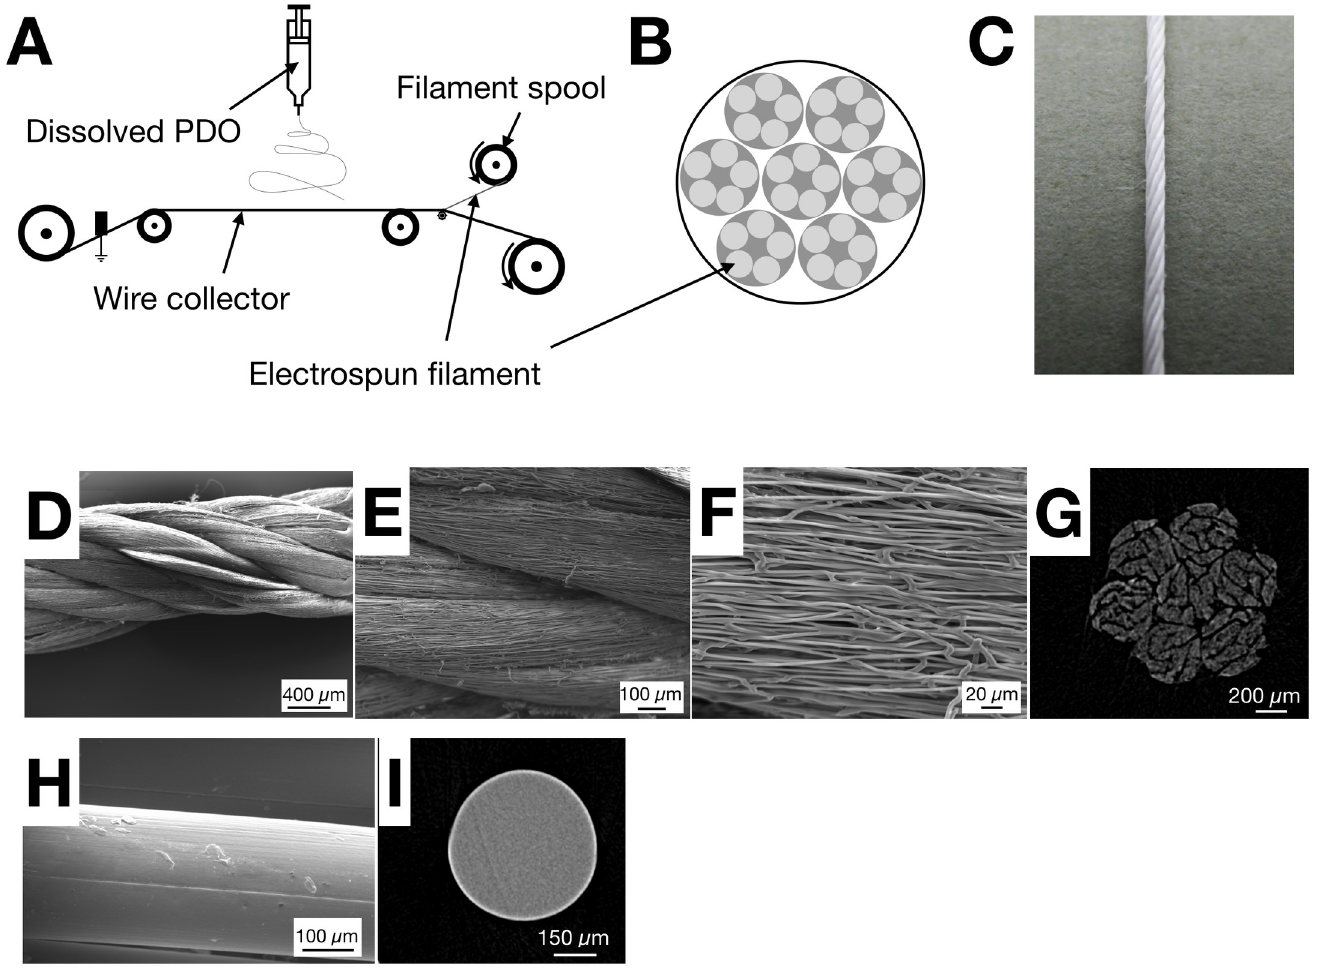
Fig 2. Production and characterisation of electrospun (ES) suture. A) Schematic illustrating the setup for producing ES filaments (building blocks). B) Schematic of the ES multifilament suture structure produced through the two-step twisting process. C) Digital photograph showing a complete ES suture. D-F) SEM images showing the twisted multifilament ES suture at different magnifications: 50X (D), 250X (E) and 1000X (F). G) MicroCT image showing the cross section of the ES suture. Note the similarity with the schematic shown in B and the spaces between filaments for potential cellular infiltration. H) SEM image of monofilament (MF) suture. I) MicroCT image showing cross section of monofilament suture